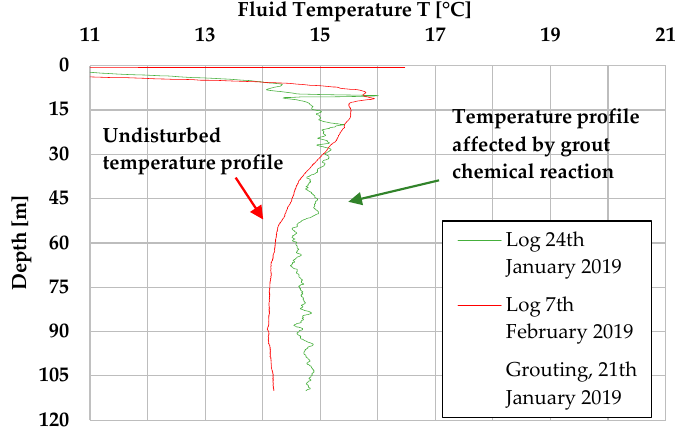
Figure 4. Vertical ground temperature profiles at the FAE-1 pilot borehole heat exchangers (BHE) during the grout hydration period (24 January profile) as compared to one at the end of the chemical reaction, 15 days later.